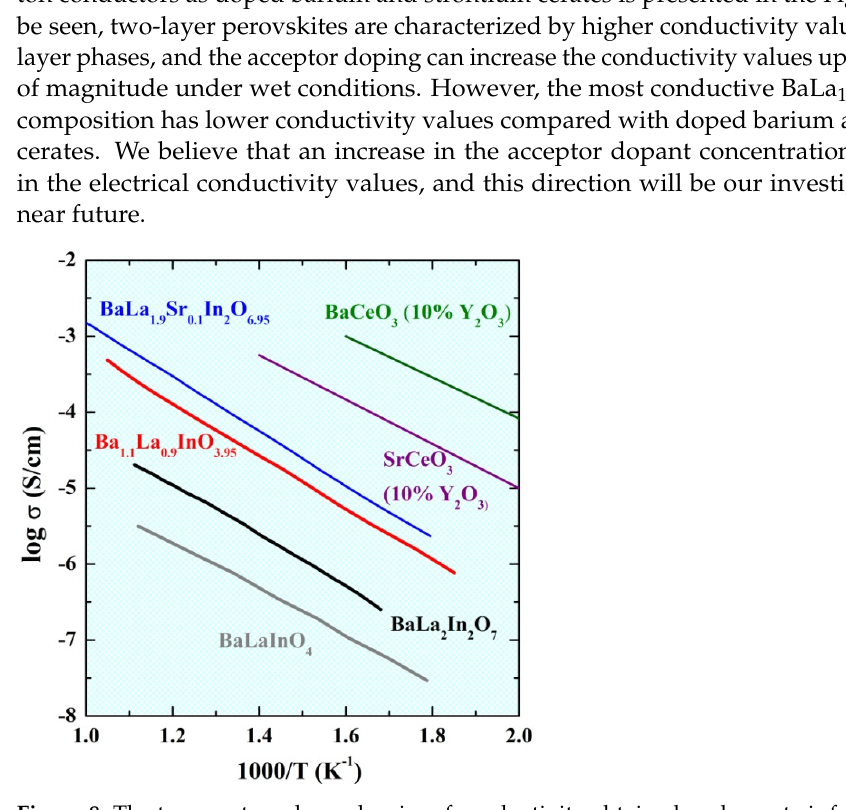
Figure 7. The temperature dependencies of protonic conductivity for the investigated compositions BaLa 2 In 2 O 7 (1), BaLa 1.9 Ca 0.1 In 2 O 6.95 (2), BaLa 1.9 Sr 0.1 In 2 O 6.95 (3), BaLa 1.9 Ba 0.1 In 2 O 6.95 (4).